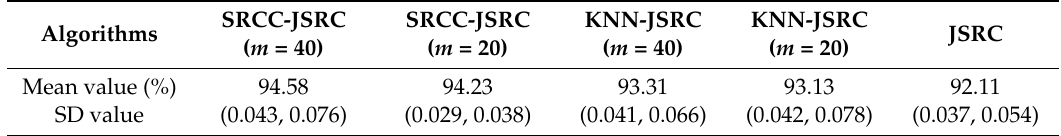
Table 3. The statistical results the best accuracy from all selected algorithms.